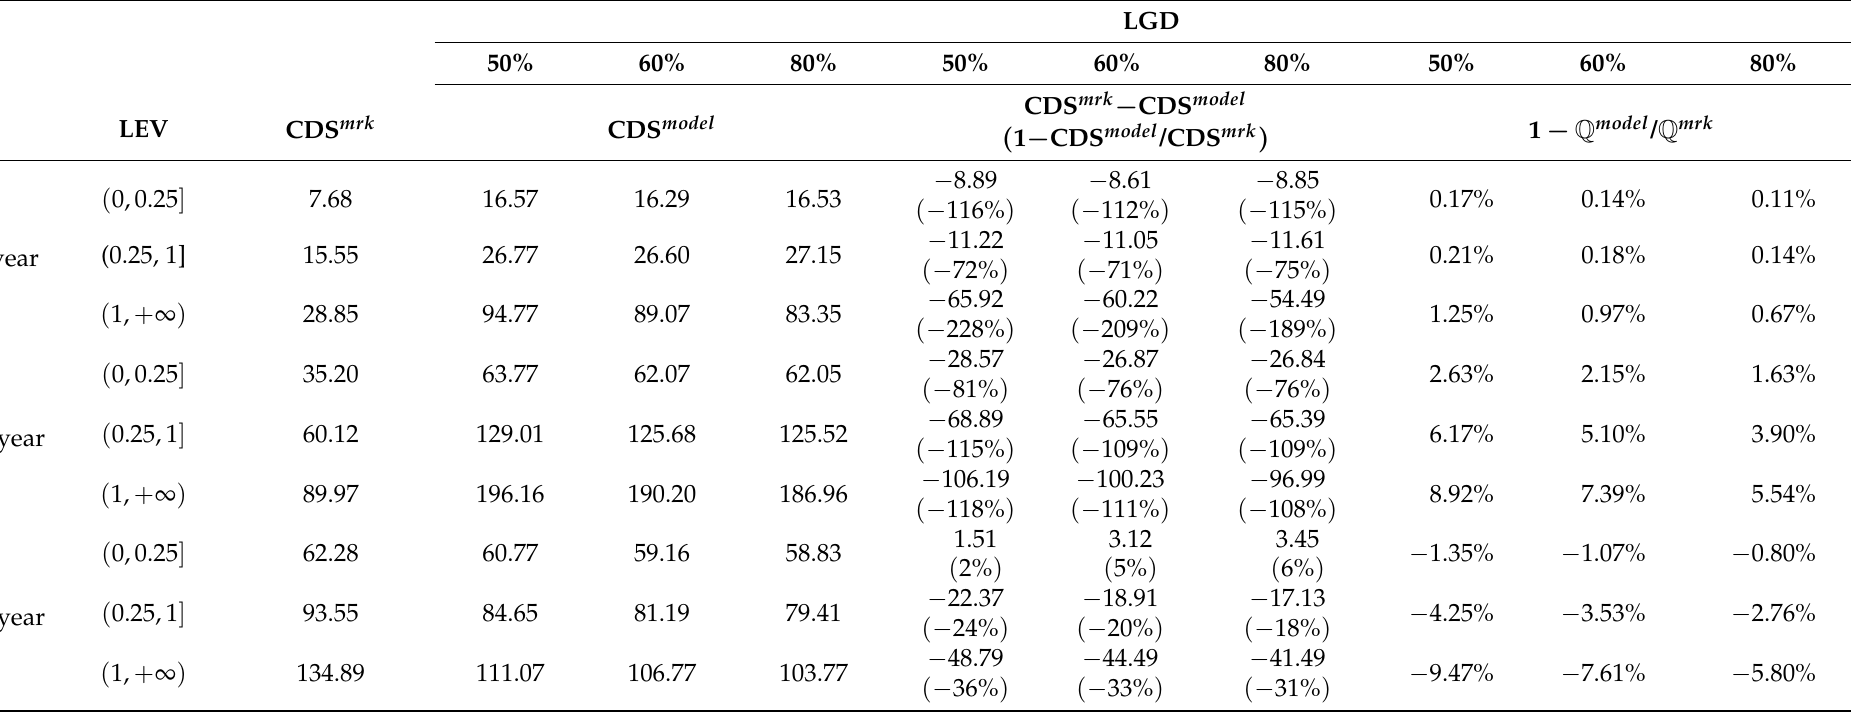
Table 4. Pricing error of the CDS spread and risk-neutral probabilities of default for w = 2/3. All the model-implied spreads are calculated setting the loss given default equal to 50%, 60% or 80%. This allows to jointly test for the effect of the aggregation scheme in the firm’s capital structure and on the selected value of LGD. The table reports the market CDS spread alongside those produced by the model (expressed in basis points) based on the estimates of the firm’s asset and volatility on the previous week. The results are clustered based on the maturity of the CDS contract (1, 5, and 10 years) and on the firm’s average leverage. A positive/negative pricing error CDS mrk − CDS model indicates that the model under/overpredicts the level of the spread. This is reflected into the over/underprediction of the survival probabilities. Errors are also reported as percentages in brackets. For the probabilities of survival, only percentage errors are reported. Based on leverage, the number of companies in each bucket are N ( 0,0.25 ] = 44, N ( 0.25,1 ] = 15, N ( 1, + ∞ ) =